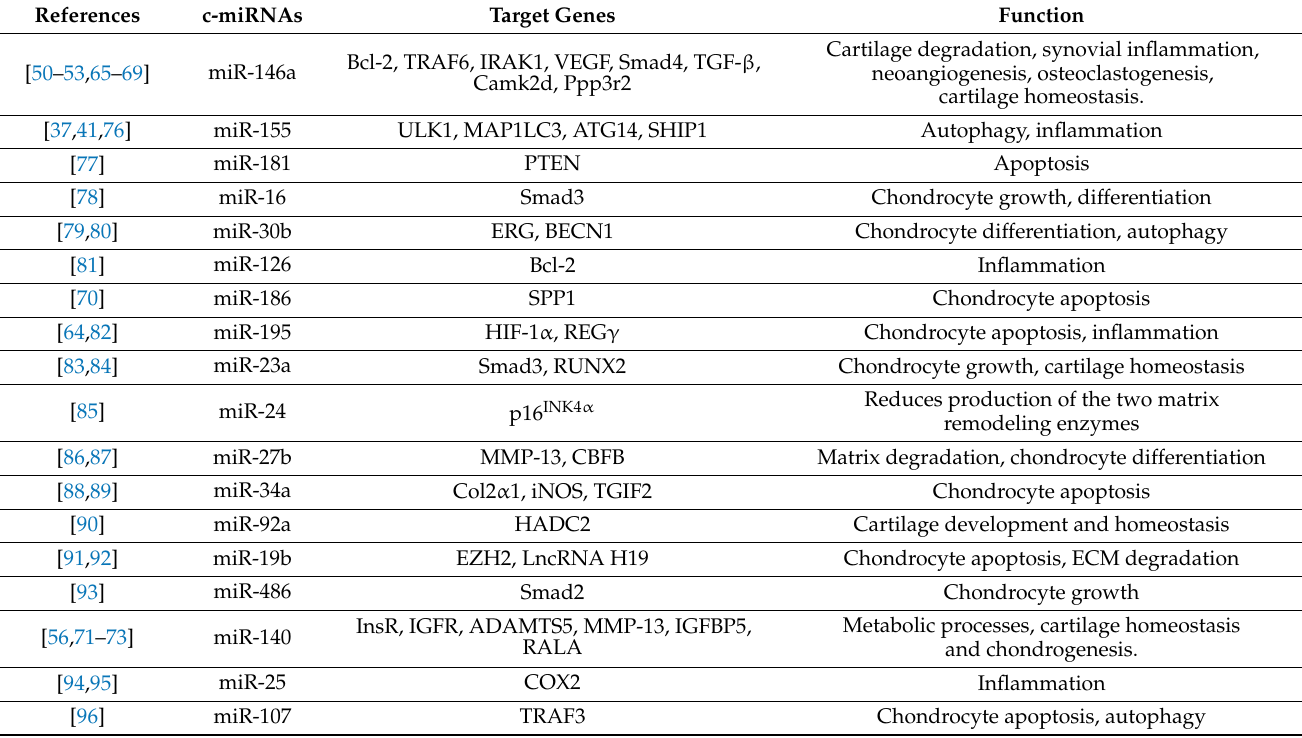
Table 3. Experimentally verified target genes of c-miRNAs involving